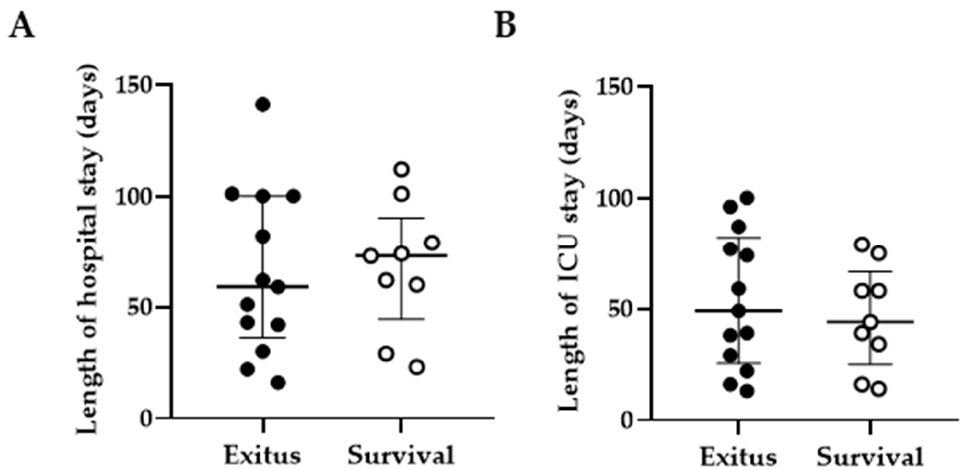
Figure 1. Length of hospital and ICU stay. Length of hospital ( A ) and ICU ( B ) stay (days) in individuals with critical COVID-19 who were divided into two groups according to the final outcome: fatal outcome, Exitus group (filled dots); or recovery and hospital discharge, Survival group (blank dots). Each dot corresponds to one individual, and vertical lines represent mean ± standard error of the mean (SEM). Statistical significance between groups was calculated using Mann–Whitney